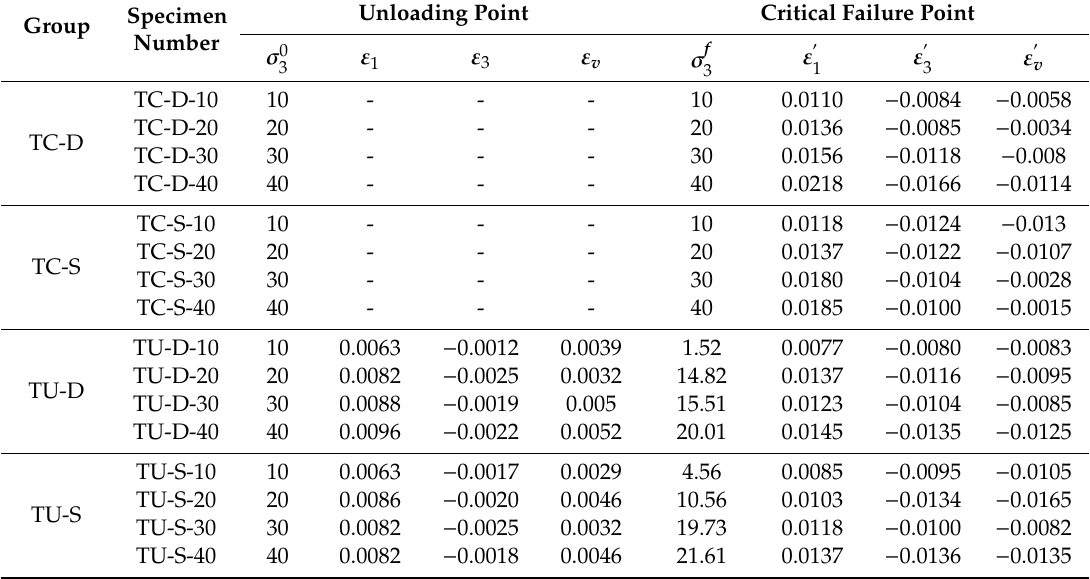
Table 3. Critical strain values of sandstone specimens at the unloading point and the critical failure point of sandstone specimens.